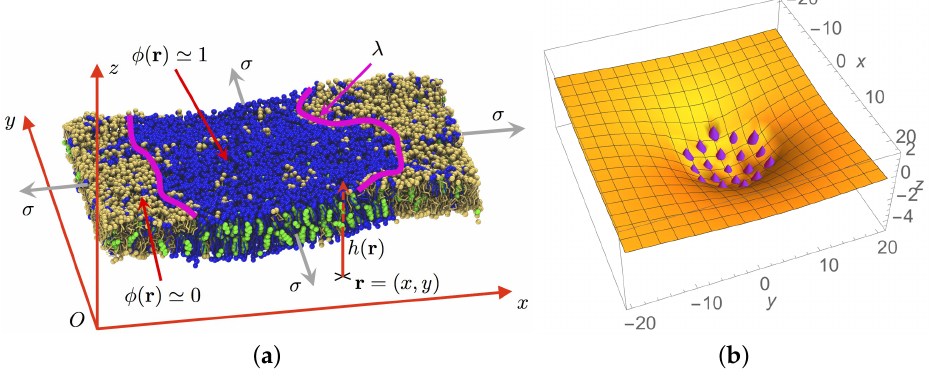
Figure 1. ( a ) Membrane simulation snapshot. The blue lipids are 1,2-dipalmitoylphosphatidylcholine (DPPC), the yellow ones di-C16:2-C18:2 PC (DIPC) and cholesterol appears in green. The pink thick line is the 1D interface delimiting the liquid-ordered (Lo) phase (cholesterol rich, φ ( r ) 1) and the (cid:39) liquid-disordered (Ld) phase (cholesterol poor, φ ( r ) 0). This interface has an energy cost per unit (cid:39) length, homogeneous to a force λ , named the line tension. Although fluctuating, the membrane is globally planar and parallel to the plane ( xOy ) . The height of the membrane above this reference plane ( xOy ) is measured by the height function z = h ( r ) . The membrane is taut with surface tension σ as illustrated by the four gray arrows parallel to the plane ( xOy ) . Adapted from an original membrane image generated by the MARTINI force field, reproduced with the courtesy of Matthieu Chavent. ( b ) In the cluster-phase scenario, proteins are described as individual objects embedded in a continuous fluctuating 2D lipid mattress, also represented by a height function. They gather because of short-range attractive forces but long-range repulsion between clusters limits their growth. In the present case, each individual protein (in purple) locally imposes a spontaneous curvature to the membrane that is represented as an elastic sheet (in orange). In a taut membrane, an effective long-range repulsion between proteins ensues (see text). The units are